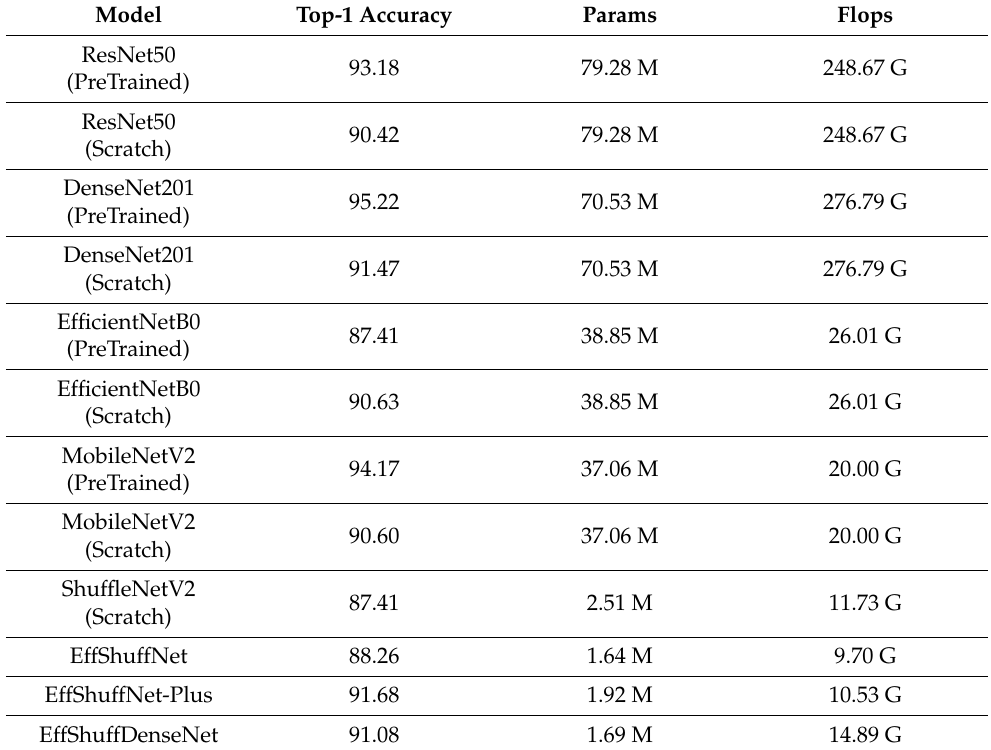
Table 6. Experimental results of NA Birds